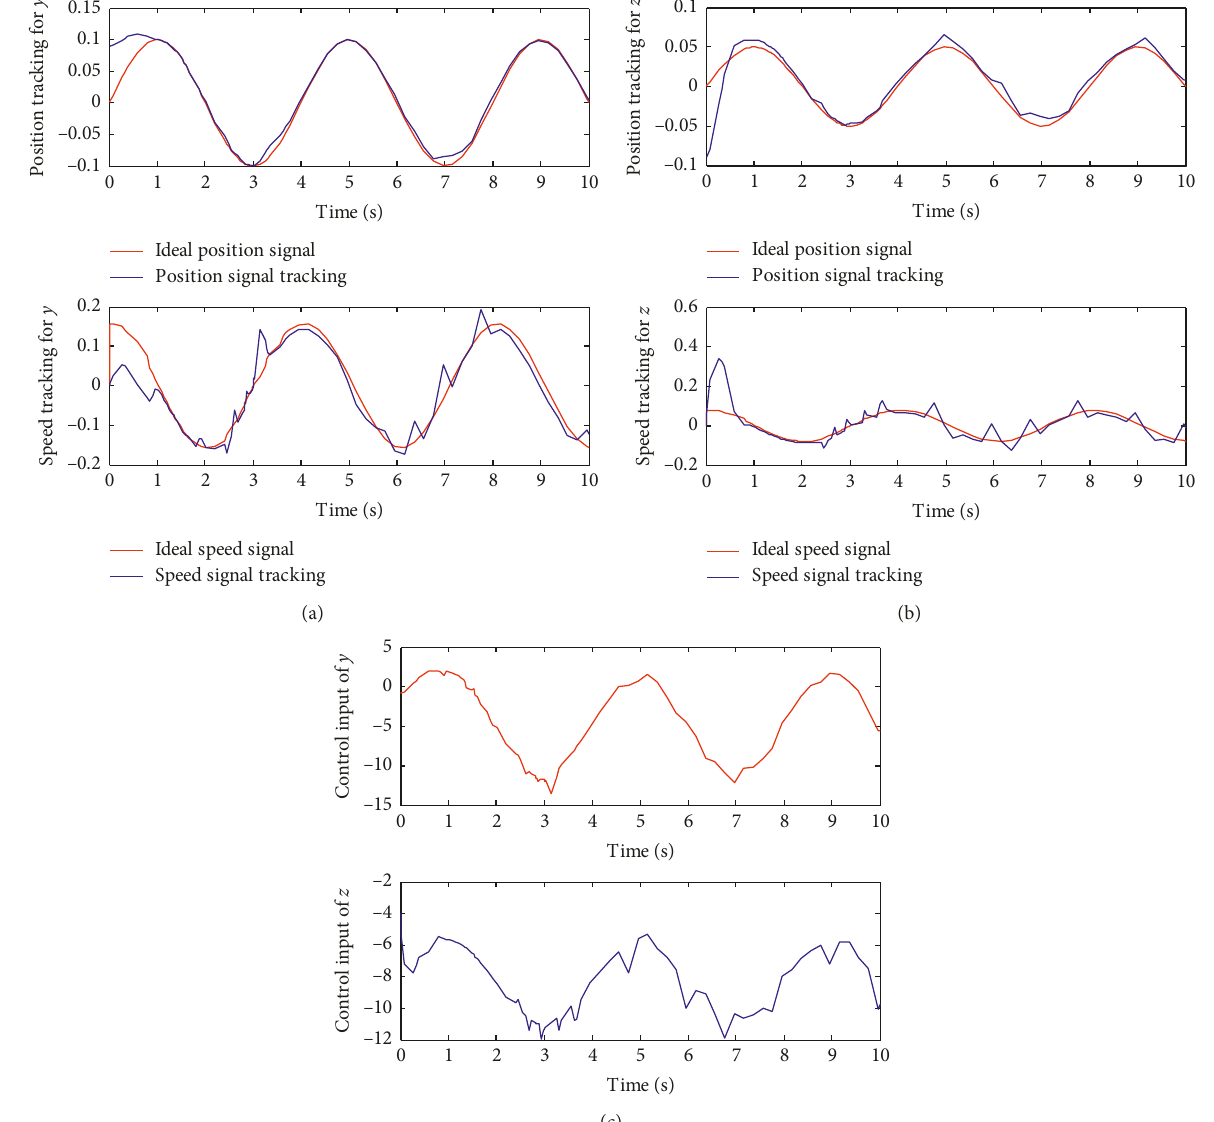
Figure 4: The displacements (position signal tracking curves) and velocities (speed signal tracking curves) of flap(z)/lead-lag(y) motions, and the signals of control inputs, controlled by the nominal SMC algorithm based on the upper bound